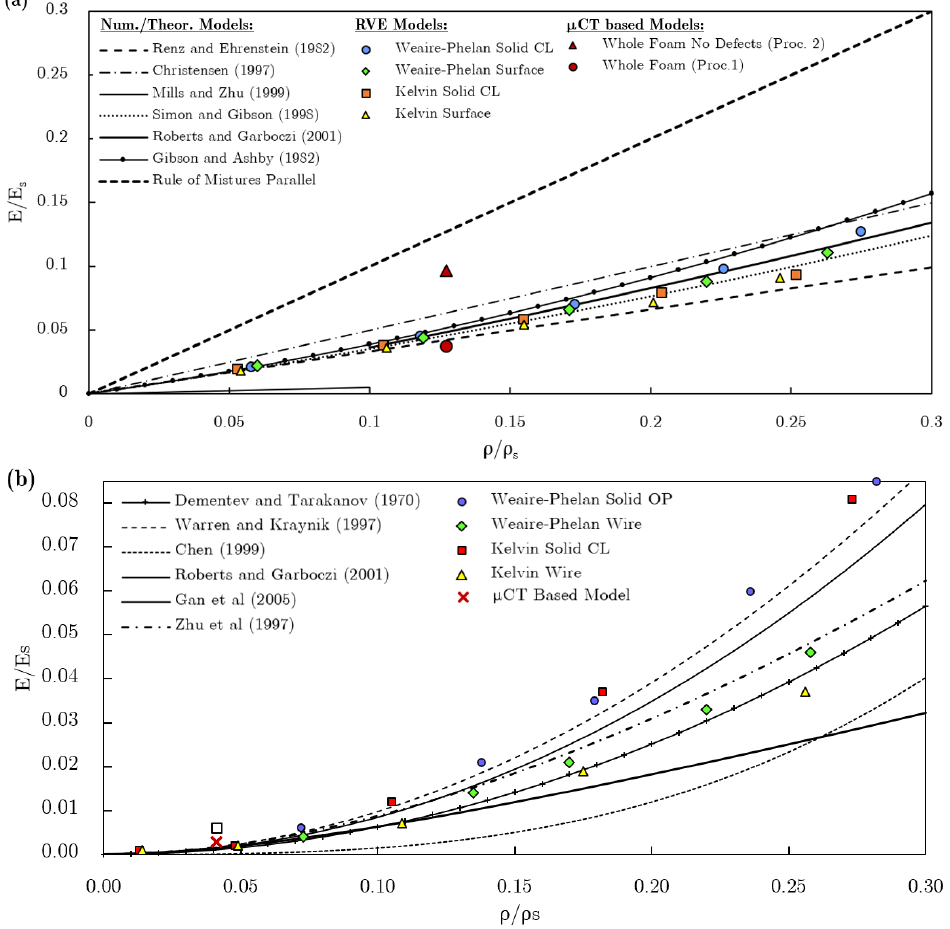
Figure 19. Relative Young’s modulus of µ CT based models and RVE models for the ( a ) closed-cell foam specimen and ( b ) the cubic open-cell foam